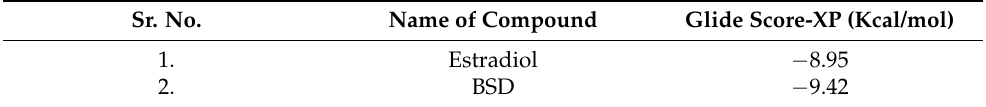
Table 2. Summary of GlideScore of Estradiol and